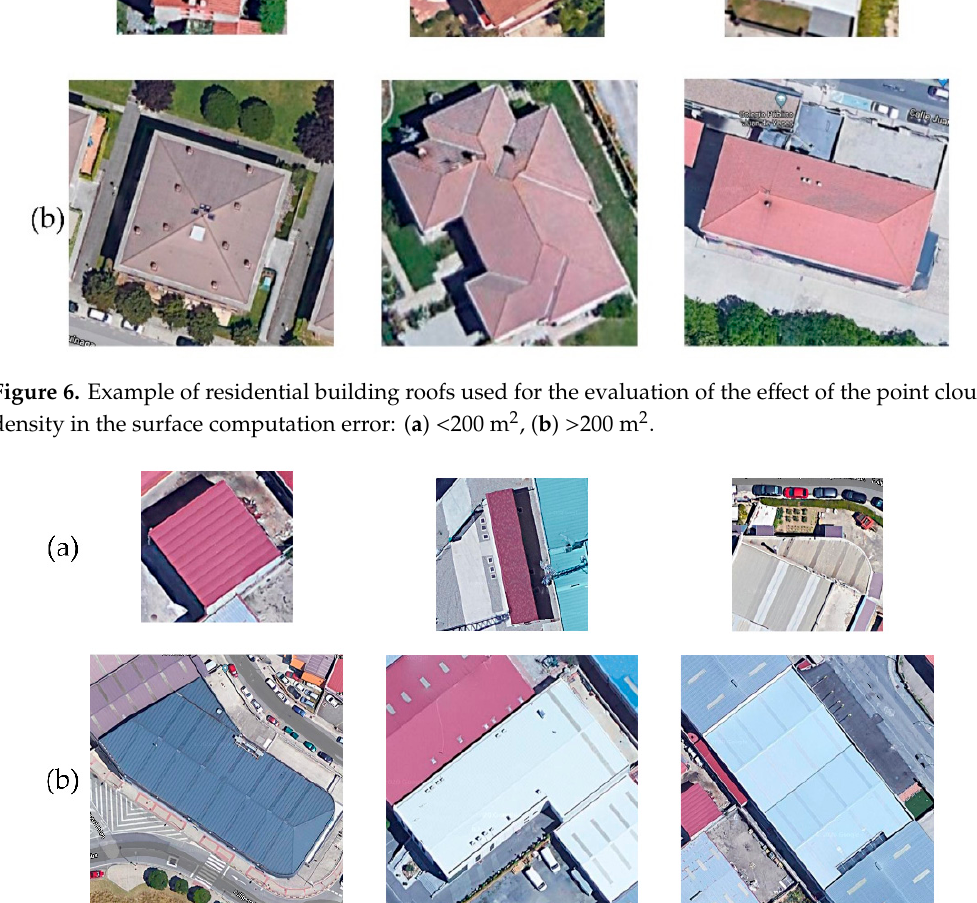
Table 4. Main features of the first coverage LiDAR data.